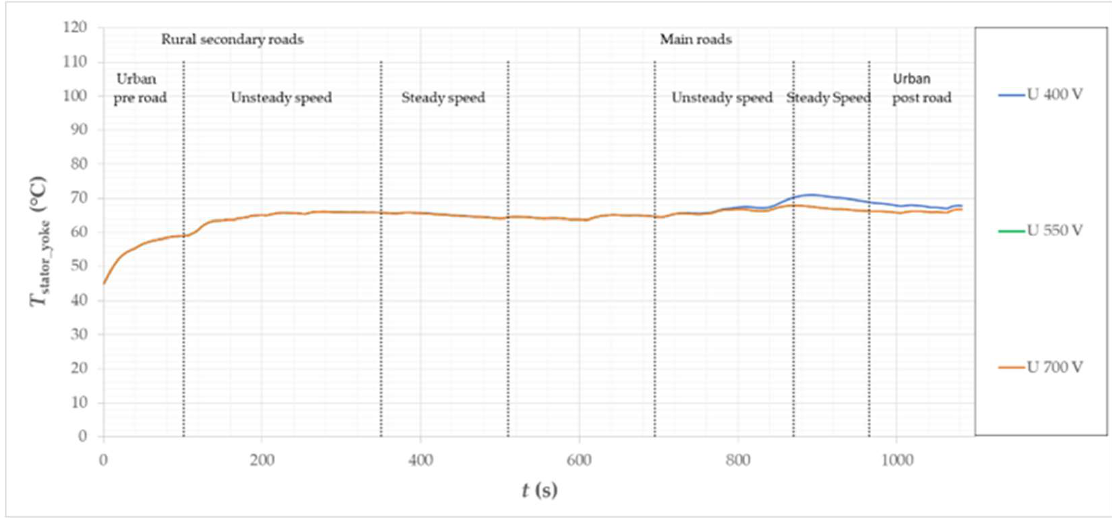
Figure 29. Calculated waveforms of temperatures in the stator yoke for the considered vehicle on the Artemis Road drive cycle .